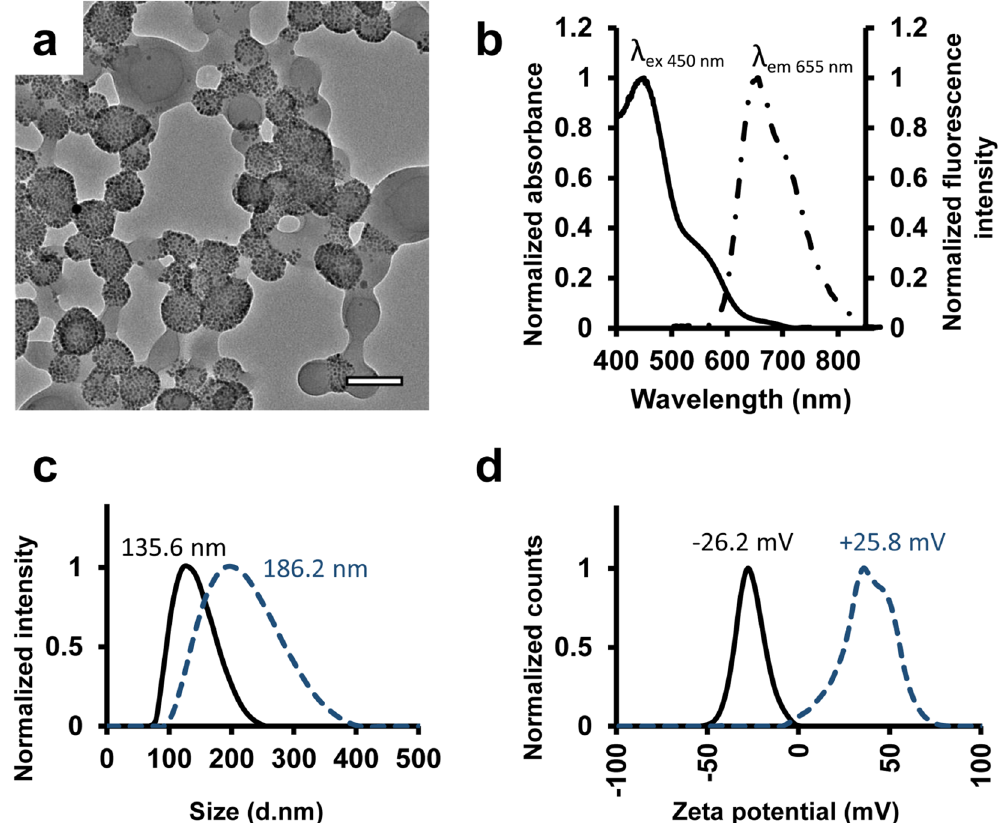
Figure 1. Nanoparticle characterisation. ( a ) TEM image of PGMA-PEI nanoparticles, scale bar: 100 nm. ( b ) Excitation (solid line) and emission (discontinuous line) spectra of PGMA/PGMA-PEI nanoparticles containing P10 fluorophore. ( c ) Hydrodynamic size distribution of PGMA (solid) and PGMA-PEI (discontinuous) nanoparticles. ( d ) Zeta potentials of PGMA (solid) and PGMA-PEI (discontinuous)